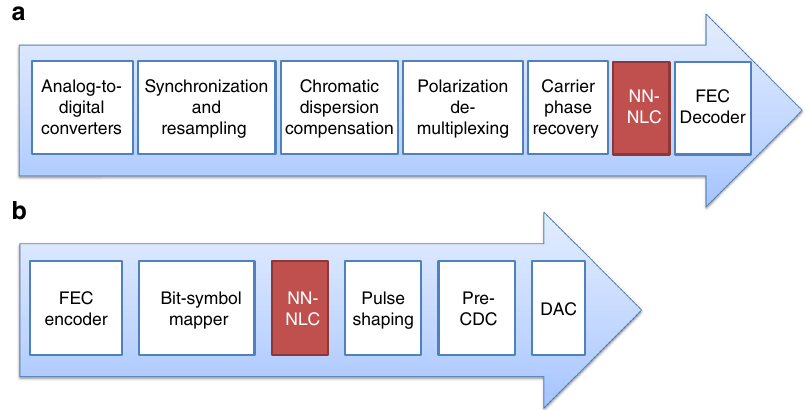
Fig. 1 DSP fl owchart with NN-NLC. a Receiver side, and b transmitter side